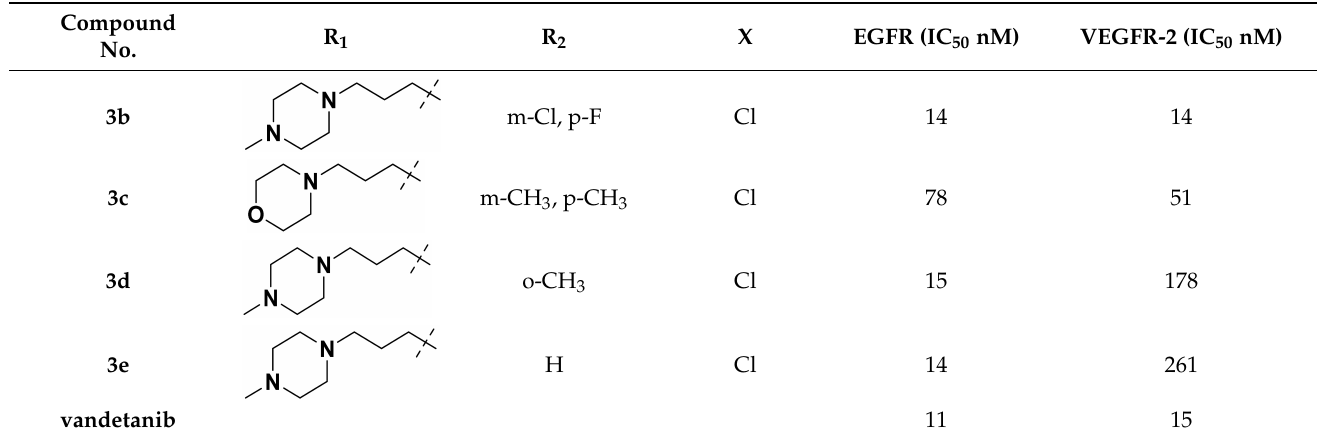
Figure 4. Structure of quinazoline-based urea hybrids and the most promising compound 3a . Table 3. In vitro cytotoxic activities of hybrid compounds 3 ( b – e ).